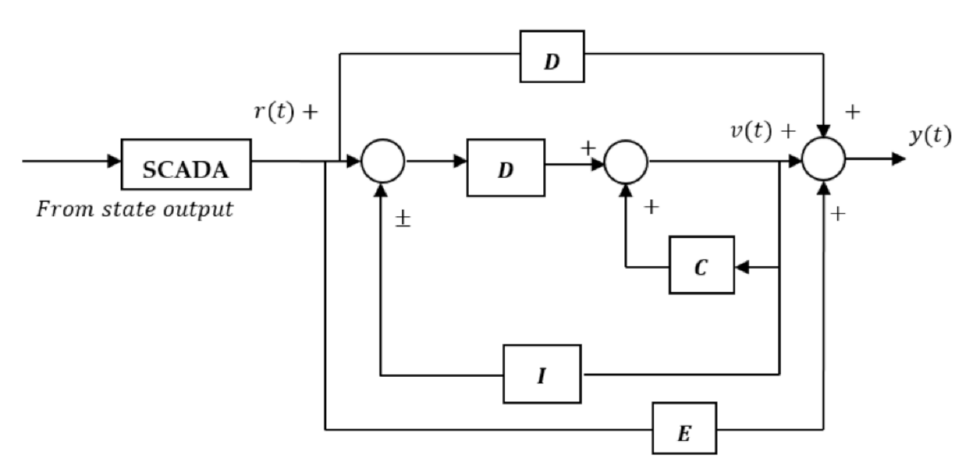
Figure 4. Closed-loop system block diagram